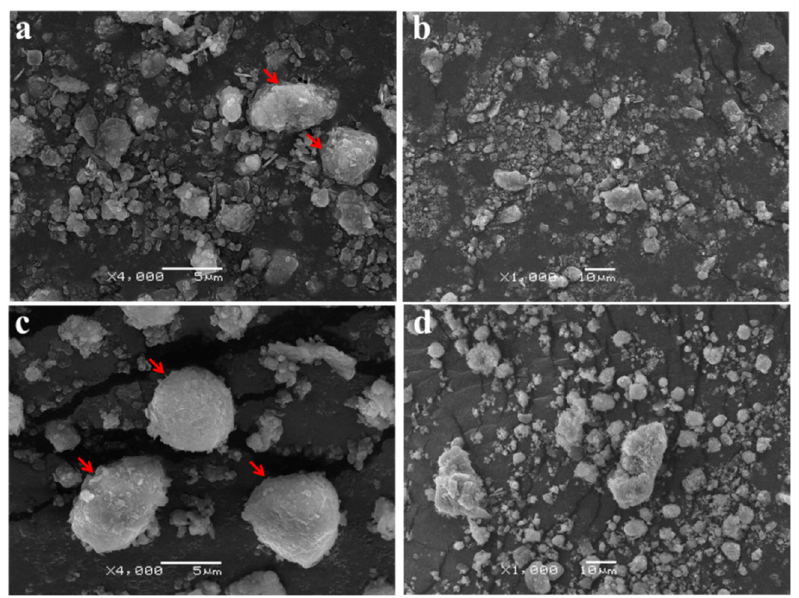
Figure 6. SEM image of BR in CK ( a , b ), without the application of ZH-1; and RX ( c , d ), with the application of ZH-1.